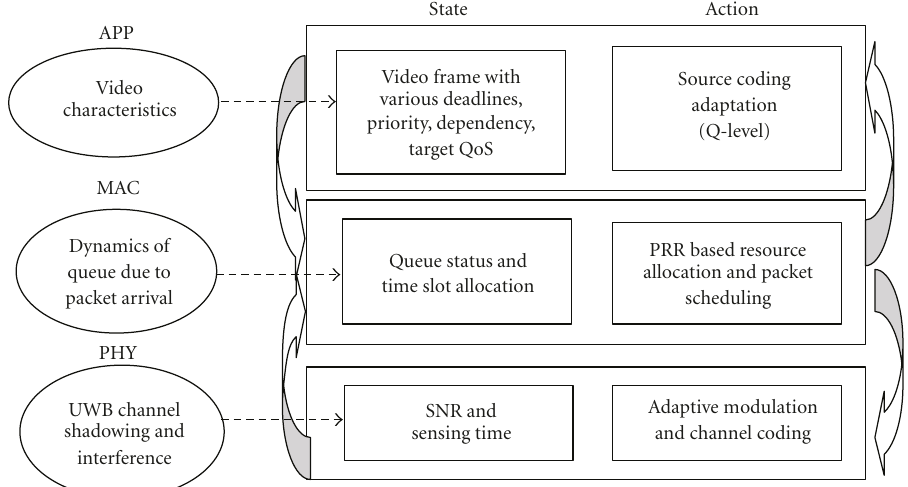
Figure 2: Proposed cross layer interactions.